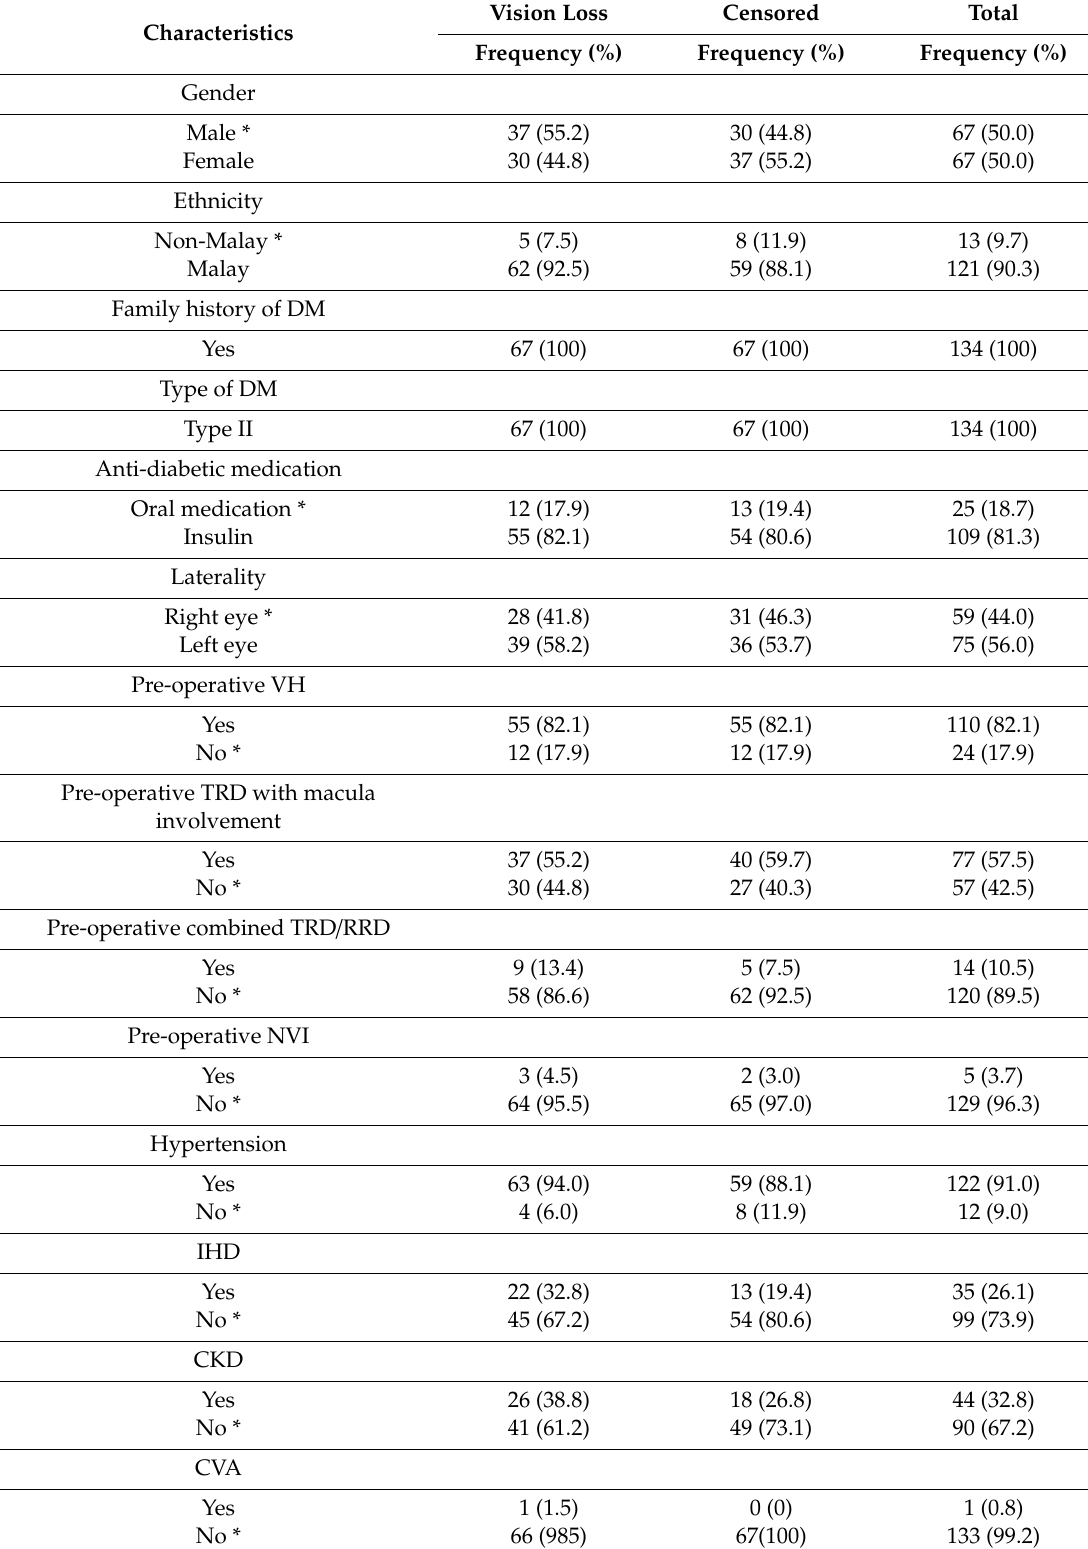
Table 1. Characteristics of subjects with visual improvement post vitrectomy for complications of PDR (n =